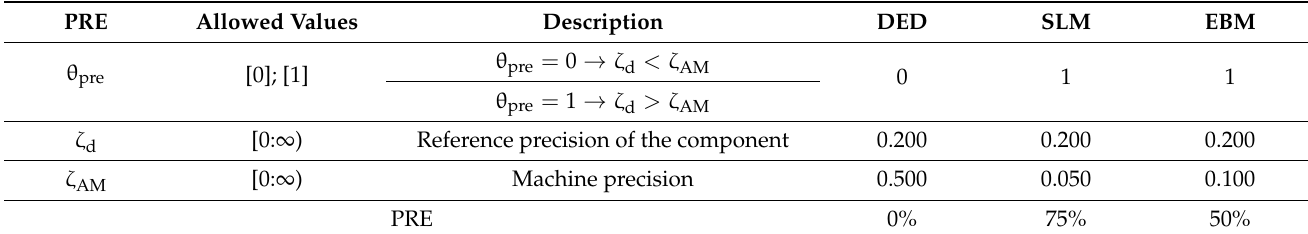
Table 4. Precision analysis (PRE) calculation for the FDM head for traditional plastics. PRE Allowed Values